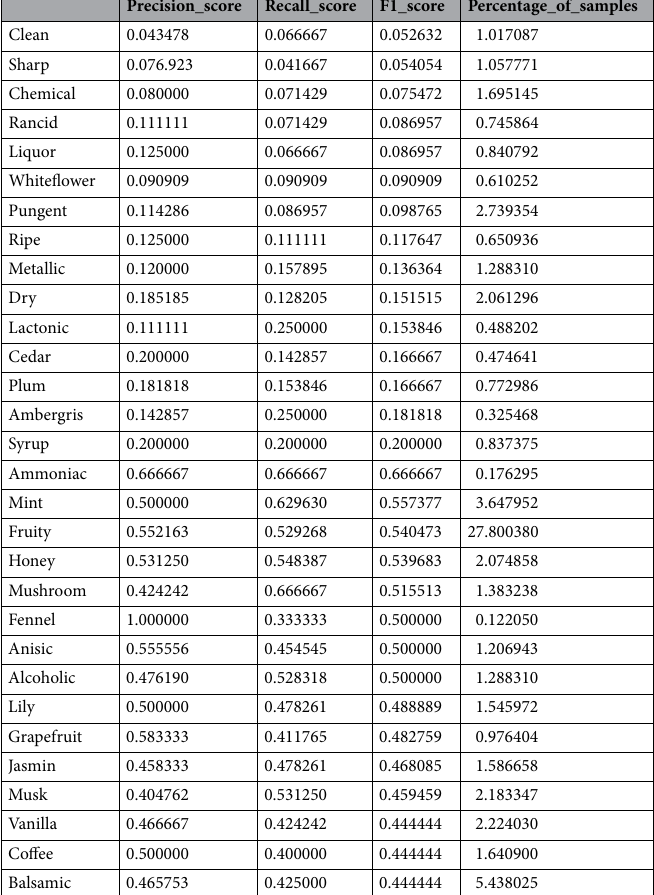
Table 5. Bottom 15 (from ‘clean’ to ‘syrup’) and top 15 (from ‘ammoniac’ to ‘balsamic’) label-wise F1_scores along with their precision and recall scores. Percentage of samples for labels was calculated on the entire dataset and not only the test